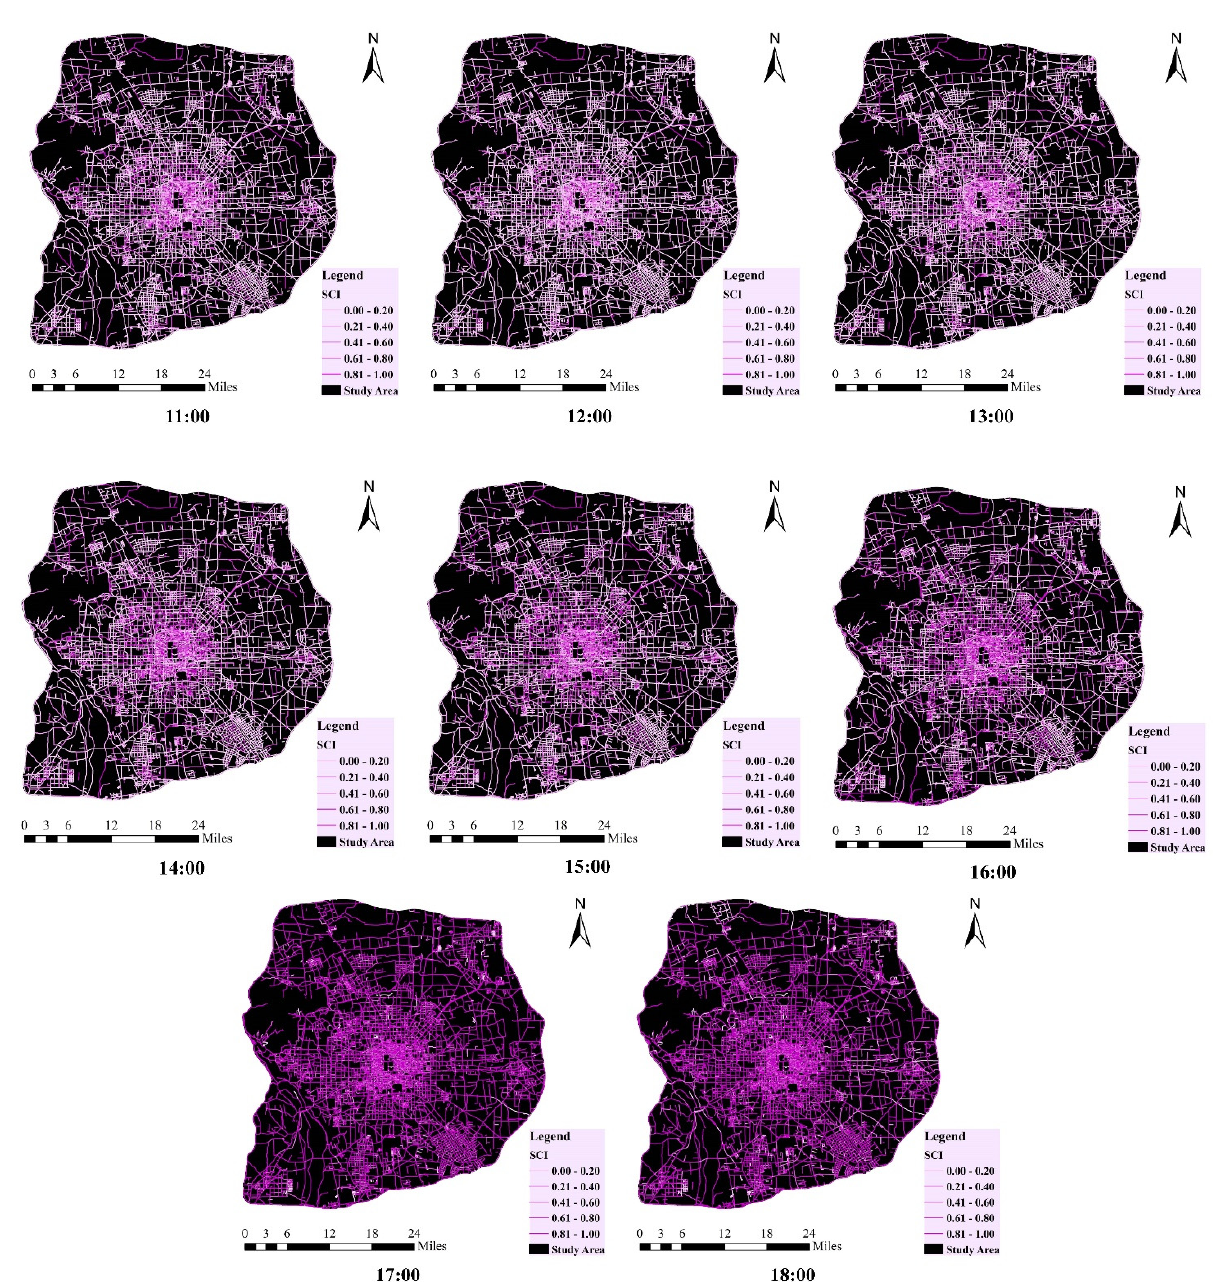
Figure 8. Spatial and diurnal distribution of shading coverage index at the scale of road section.